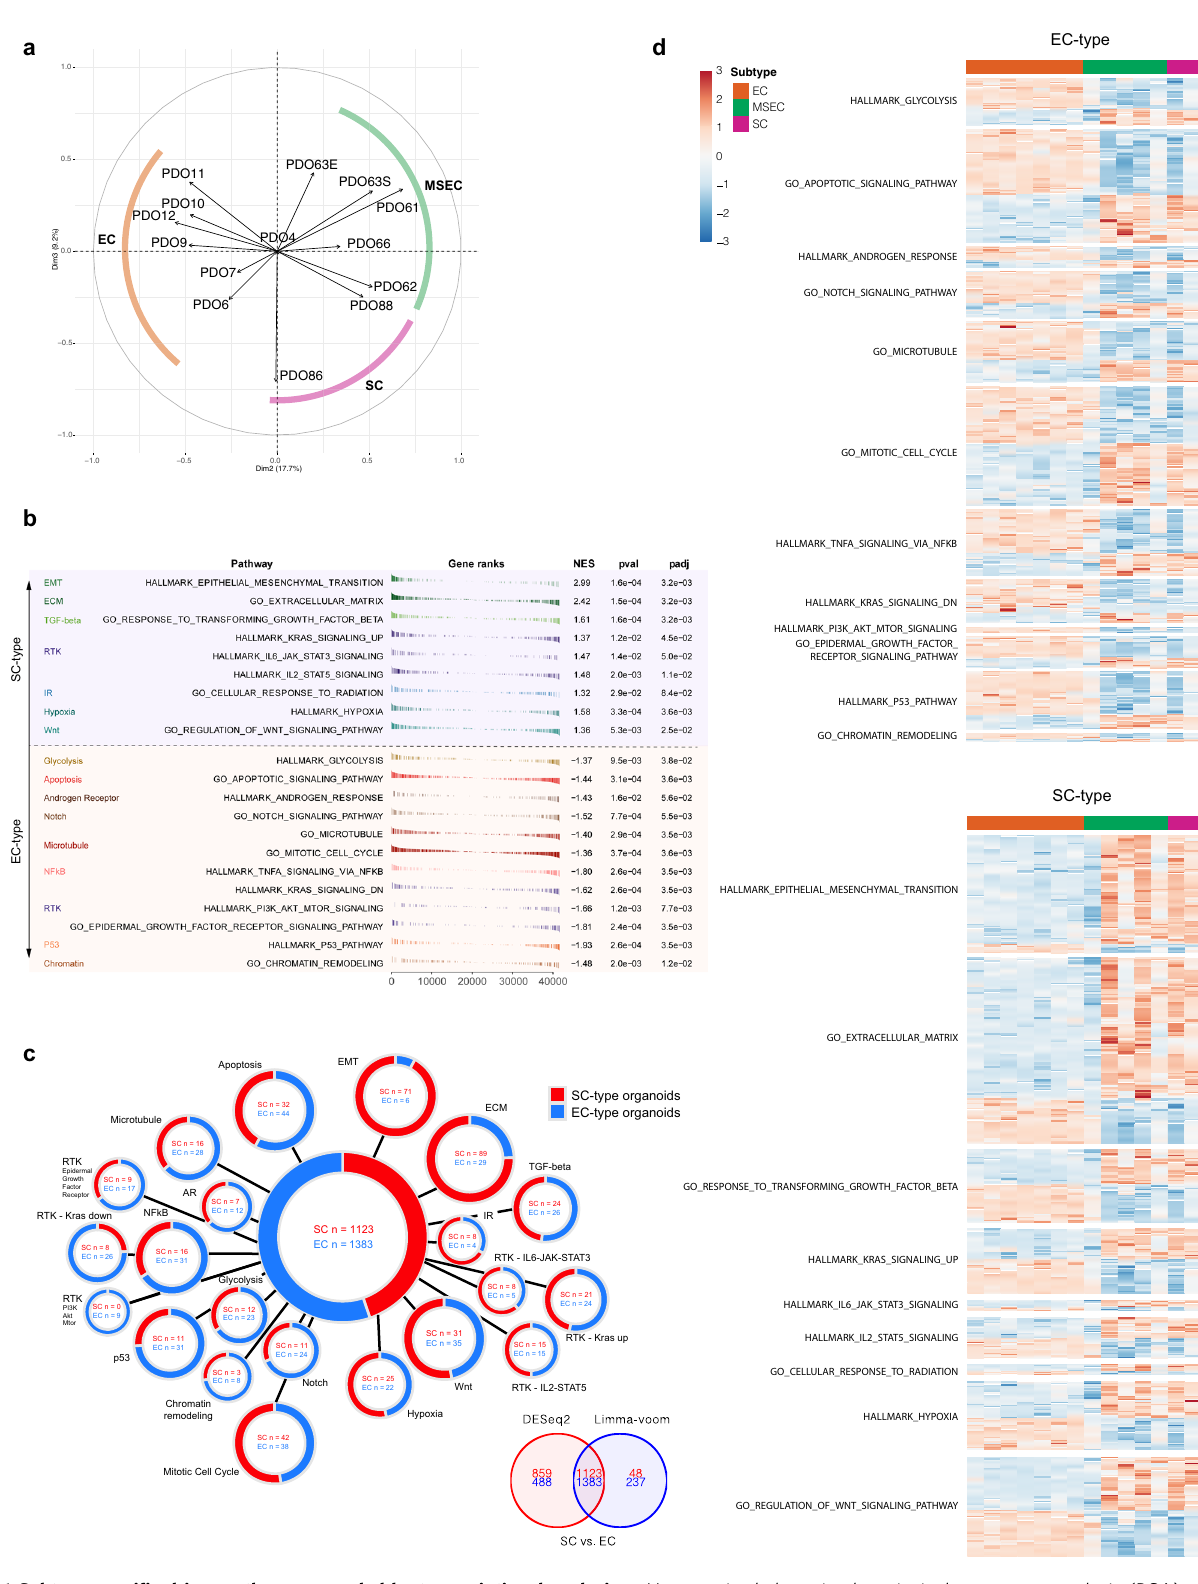
Fig. 6 Subtype-speci fi c driver pathways revealed by transcriptional analysis. a Unsupervised clustering by principal component analysis (PCA) on sample-wise PDO transcriptome. Organoids derived from the same subtypes were well clustered into the corresponding subtypes. b Top differentiated pathways between EC-type and SC-type PDOs according to GSEA enrichment analysis. c Upregulated signature genes in EC-type organoids (blue) and in SC-type organoids (red) overlapped by DESeq2 and Limma-voom. d Heatmap showing expression of differentiated signature genes between EC-type and SC-type